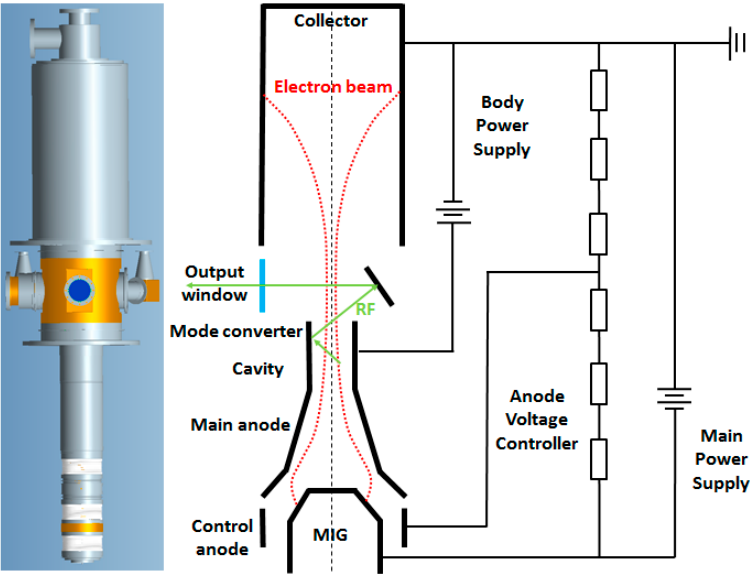
Figure 1. Model of 170 GHz gyrotron and power supply configuration.